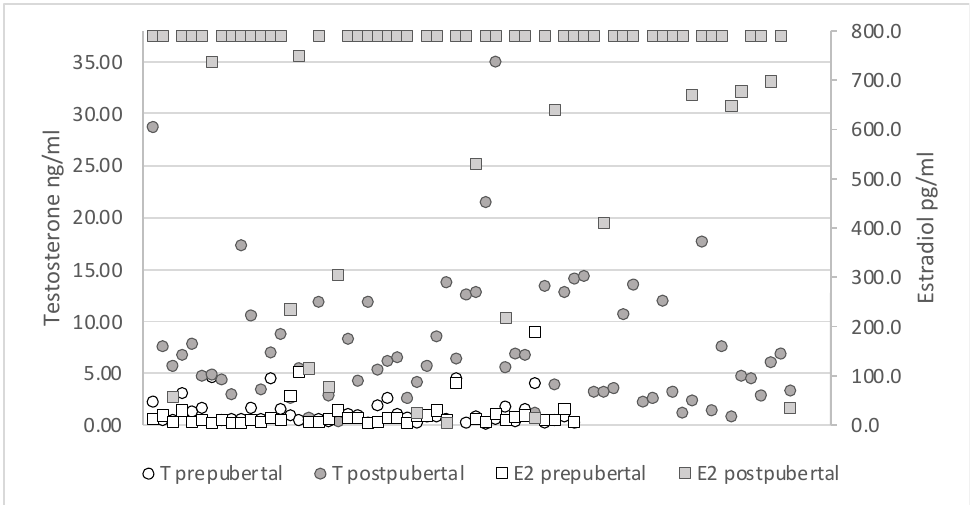
Figure 3. Overview of T and E2 levels of pre- and postpubertal wild boar males based on the definition chosen in this study. T concentrations are marked with dots and E2 with squares, respectively. Almost all prepubertal T and E2 values are concentrated on the lower limit, whereas T values of postpubertal males are distributed at higher concentrations. E2 in postpubertal males reached the upper detectable limit of the radioimmunoassay.